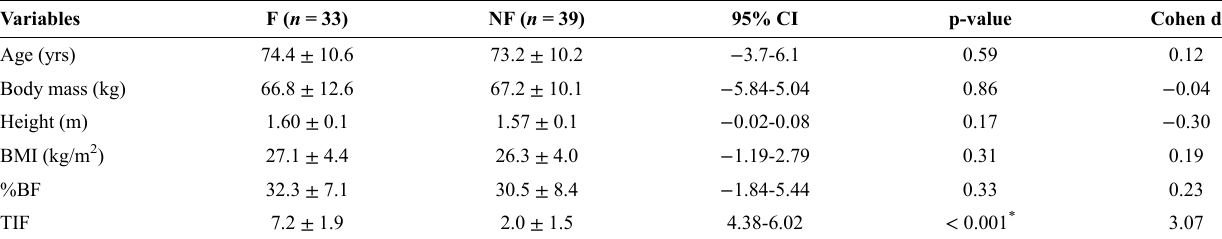
Table 1 - Participants